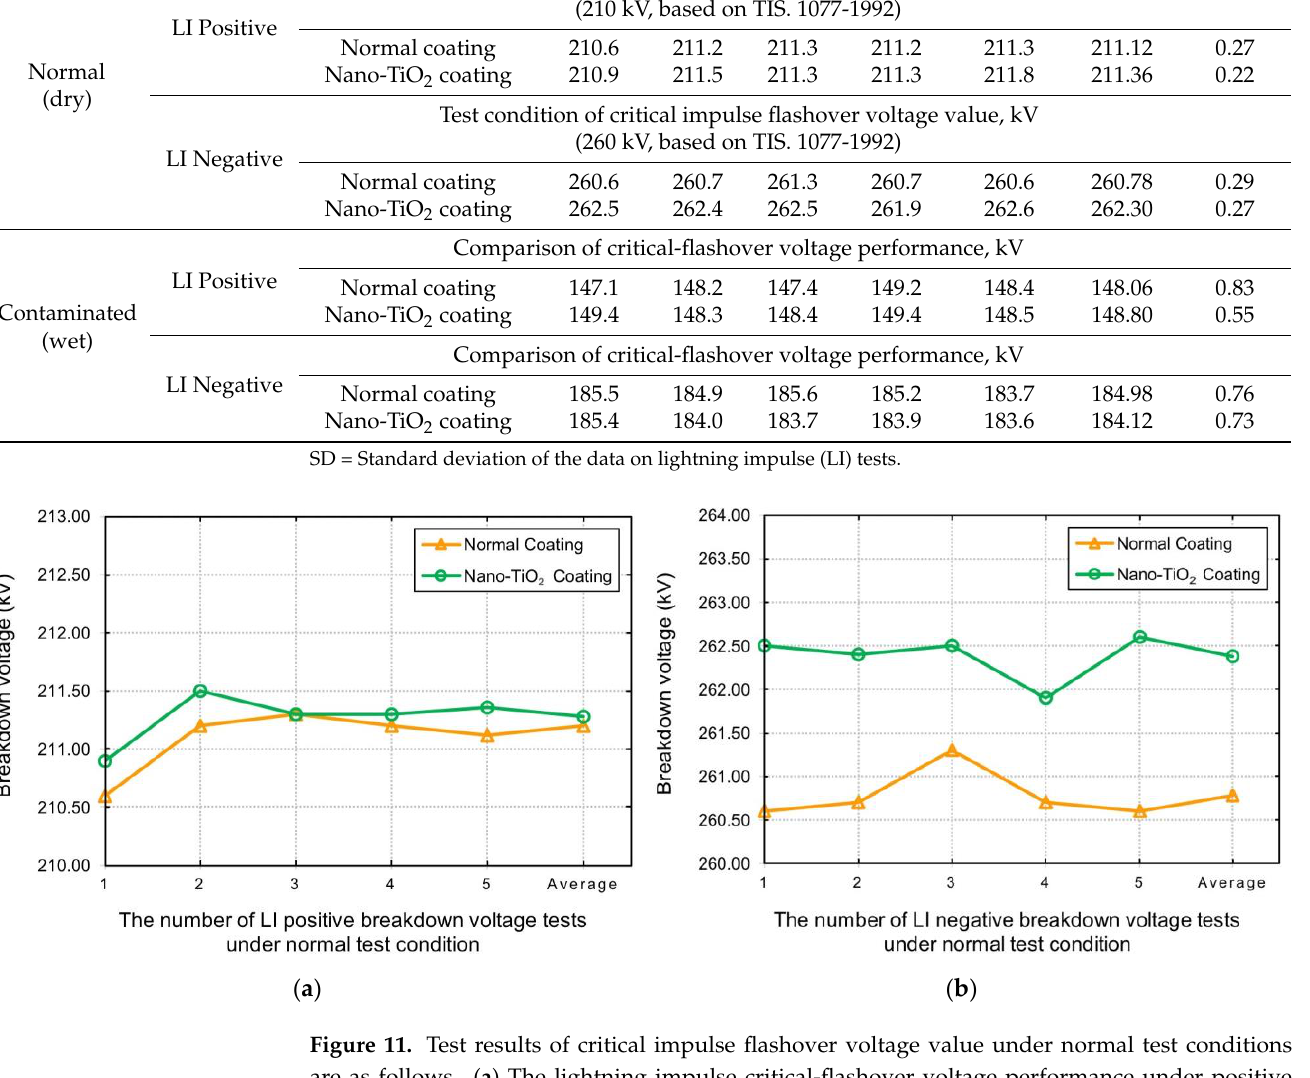
Figure 11. Test results of critical impulse flashover voltage value under normal test conditions are as follows. ( a ) The lightning impulse critical-flashover voltage performance under positive polarity testing; ( b ) The lightning impulse critical-flashover voltage performance under negative polarity testing.